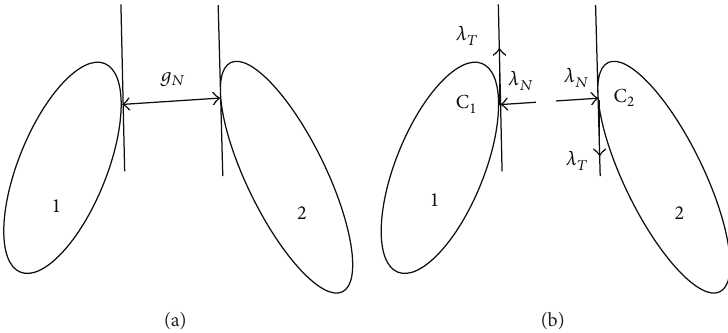
Figure 2: Sketch of rigid body contact: (a) normal distance 𝑔 𝑁 and (b) tangential and normal